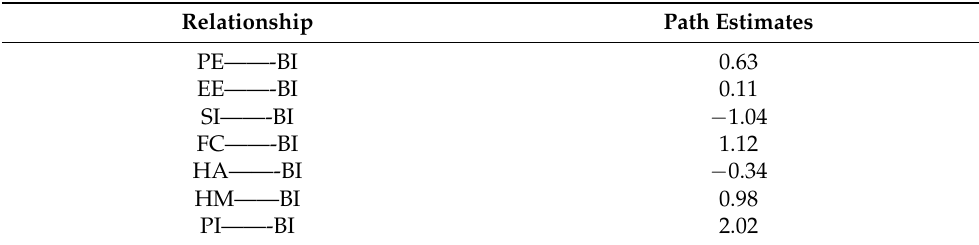
Figure 3. Structural model of all research constructs. Table 4. Path estimates of all research relationships.